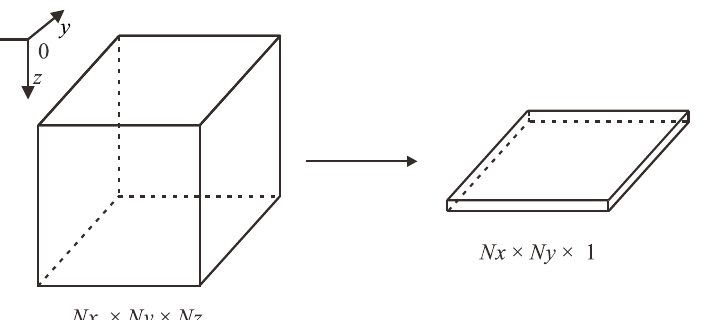
Figure 2. The schematic of a three-dimensional model and one layer of the model. Nx , Ny and Nz are the number of pixels of the model in the x , y and z directions, respectively.